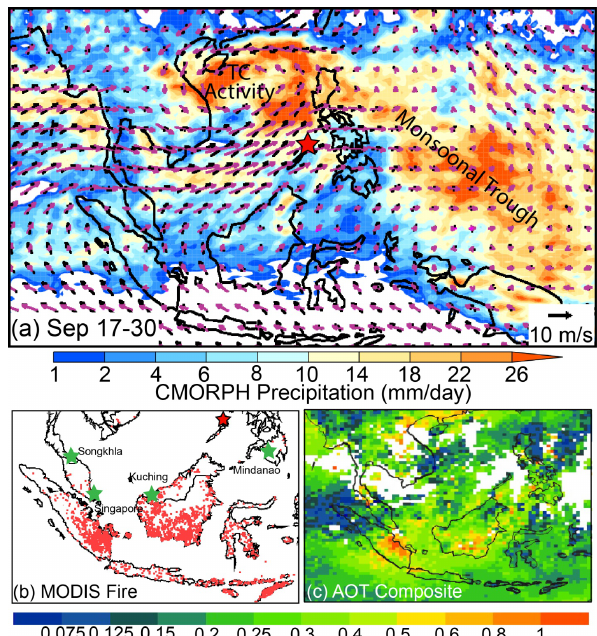
Figure 2. Overview of the aerosol and meteorological environ- ment during the 17–30 September Vasco cruise. (a) Surface (black) and 850hPa (purple) NOGAPS winds overlaid on CMORPH av- erage precipitation rain rates. (b) MODIS Terra + Aqua active fire hotspot detections during the cruise. Overlaid in green stars are key AERONET locations. Red star depicts the El Nido receptor site sampled by the Vasco . (c) Composite average MODIS + MISR aerosol optical thickness